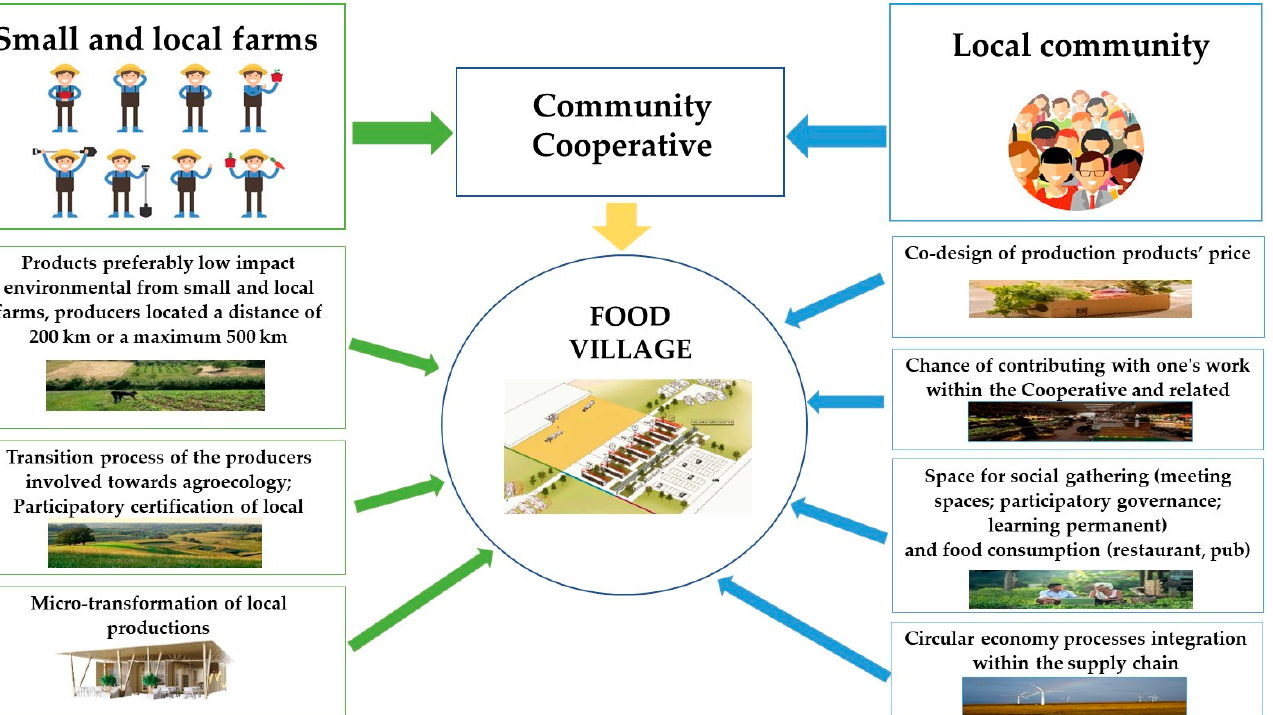
Figure 2. Food Village